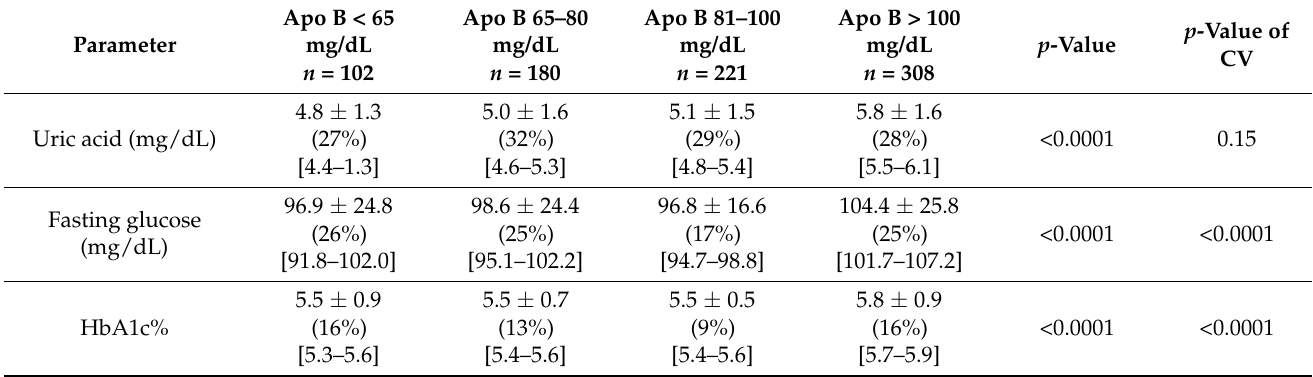
Table 4. Biochemistry parameters in the Apo B risk subgroups.